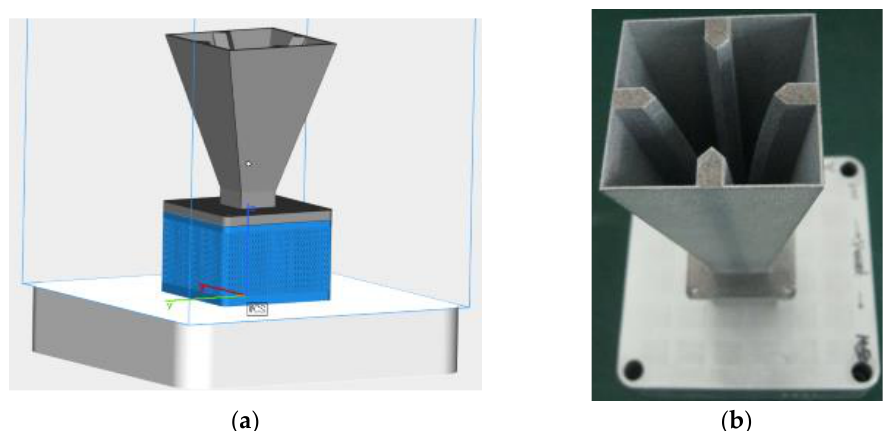
Figure 7. The waveguide part: ( a ) Three-dimensional models; ( b ) Finished parts (part volume: 19,954 mm 3 , support structures volume: 6557 mm 3 ). The values of part volume and support struc- tures volume were obtained through the three-dimensional models in the CAD software.